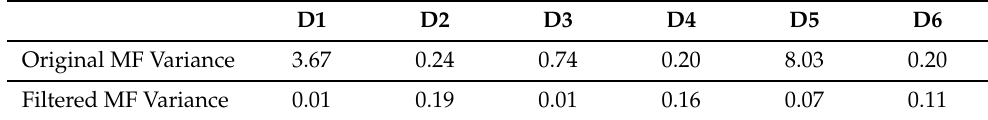
Table 4. MF intensity variance comparison.